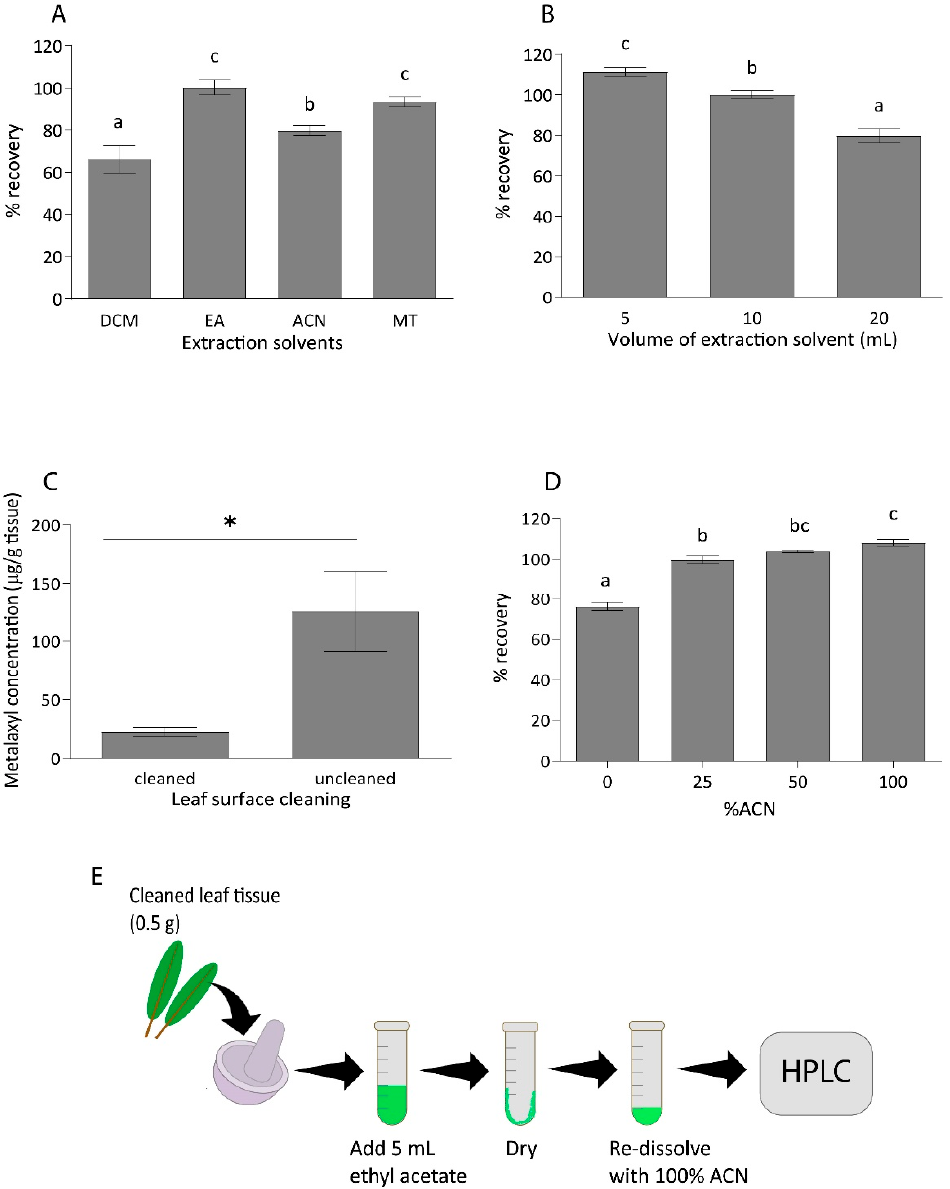
Figure 1. Metalaxyl extraction protocol development. Average percent recovery of metalaxyl in durian leaf extracted with four organic solvents: dichloromethane (DCM), ethyl acetate (EA), acetonitrile (ACN), and methanol (MT) ( A ), and with three extraction volumes: 5, 10, and 20 mL ( B ). Durian leaf samples were spiked with 100 µL of metalaxyl standard before extraction. Metalaxyl concentrations on cleaned and uncleaned leaf samples ( C ). Metalaxyl concentration after re-dissolution with 0%, 25%, 50%, and 100% ACN ( D ). ( E ) A summary diagram showing the developed protocol for metalaxyl extraction from durian leaf. Error bars with different letters show a significant difference at a significant level of 0.05. Data in ( A , B , D ) were tested with one-way ANOVA with Tukey’s HSD post-hoc test ( n = 3). The experiment in ( C ) was tested with a paired t -test ( n = 3). The asterisk (*) indicates statistically significant difference at p < 0.05.